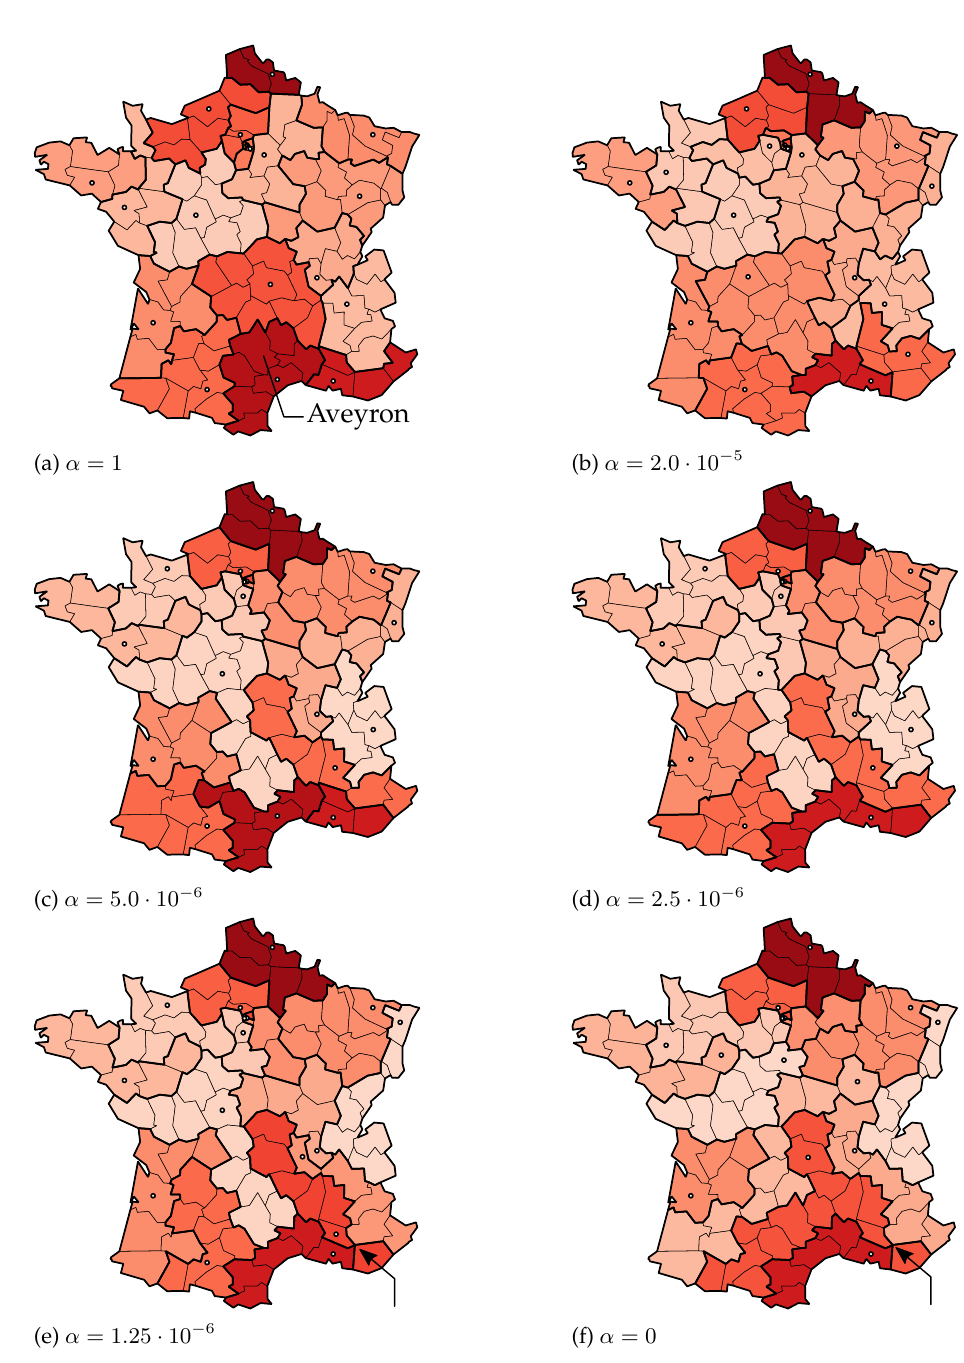
Figure 9: Output with w min equaling 5 % of France’s total population; thick lines mark aggregated regions colored according to the unemployment rate of their center ( ◦ ). The arrows in Figures (e) and (f) point to extremely narrow parts of contiguous